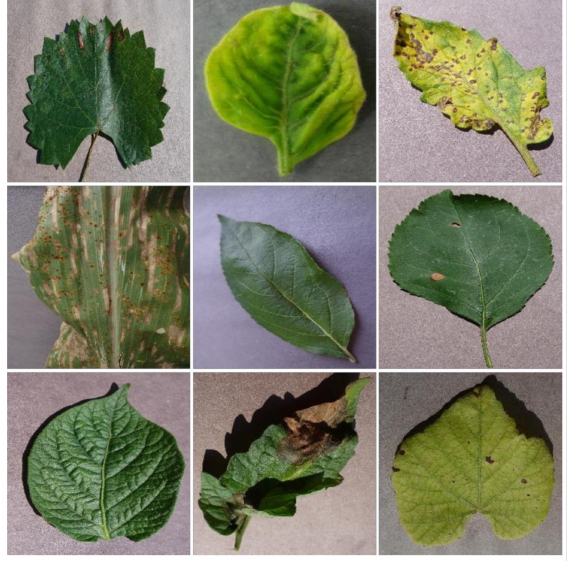
Figure 5. Some examples of the